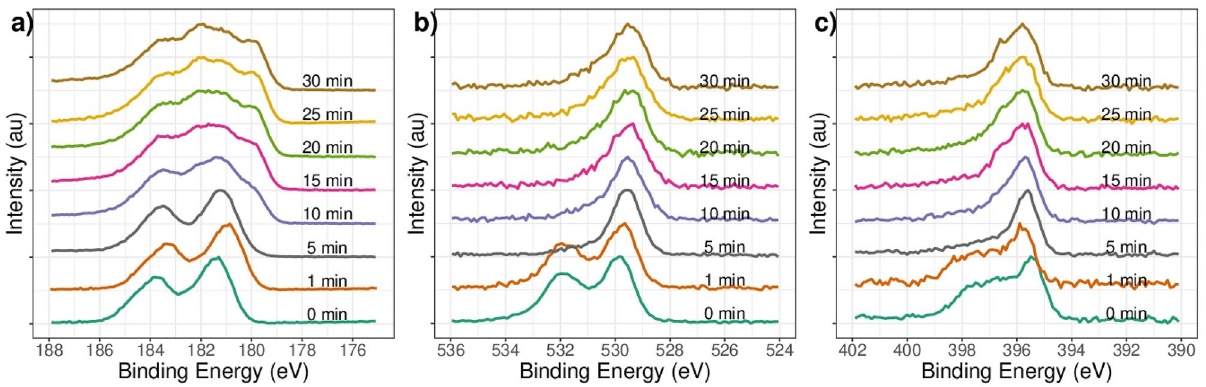
Figure 3. High-resolution XPS spectral analysis for the ( a ) Zr3d, ( b ) O1s and ( c ) N1s signals ZrN-ZrO x N y coatings for different sputter etching